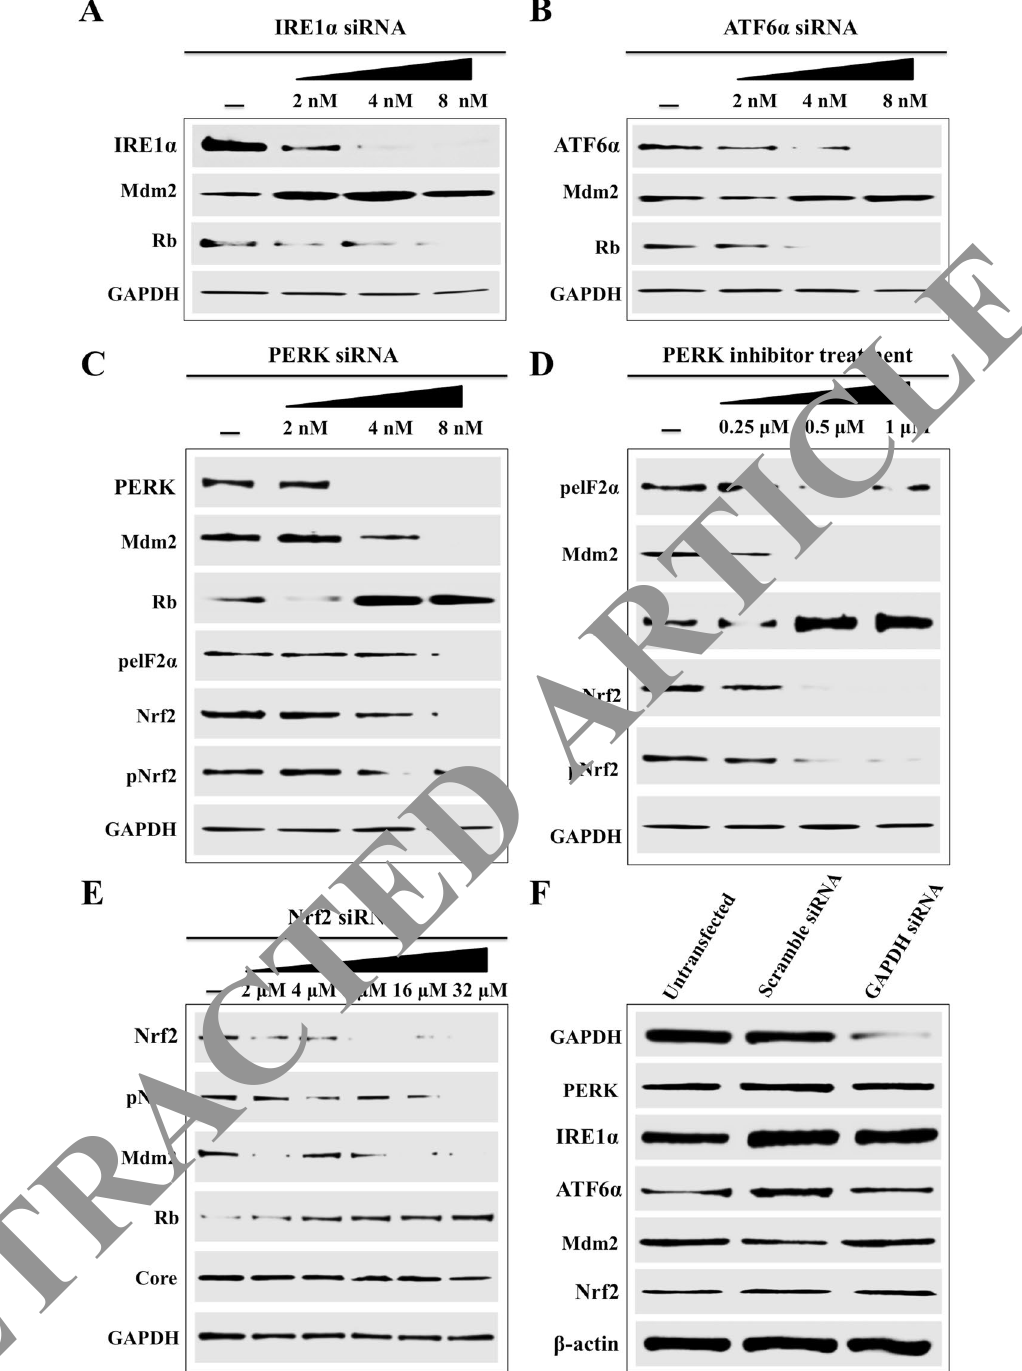
Figure 8. Activation of Mdm2/Rb degradation by ER-stress. HCV infected cells were treated with different concentrations of siRNAs targeted to three branches of UPR using lipofectamine. After 72 hours, cell lysates were prepared and 20 µ g of proteins were loaded on to SDS-PAGE. The expressions of Mdm2 and Rb levels were examined by Western blotting. (A) Knockdown efficiency of IRE1 α and its impact on the expression levels of Mdm2/Rb. (B) Knockdown efficiency of ATF6 α and its impact on the expression levels of Mdm2/Rb. (C) Knockdown efficiency of PERK and its impact on the expression levels of Mdm2/Rb. The expressions of Nrf2 and pNrf2 were examined in the same lysate. (D) Western blot for Mdm2, Rb and Nrf2 activation of HCV infected cells treated with PERK inhibitor. ( E ) Knockdown efficiency of Nrf2 and its impact on the expression levels of Mdm2/Rb. The expression of HCV core did not change during the siRNA treatment. ( F ) The levels of PERK, IRE1, ATF6, Mdm2 and Nrf2 levels were not altered in the cells transfected with scrambled siRNA or GAPDH